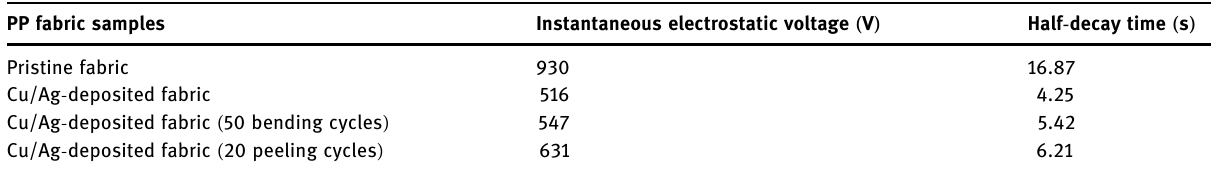
Table 3: Electrostatic results of PP fabric samples under di ff erent conditions PP fabric